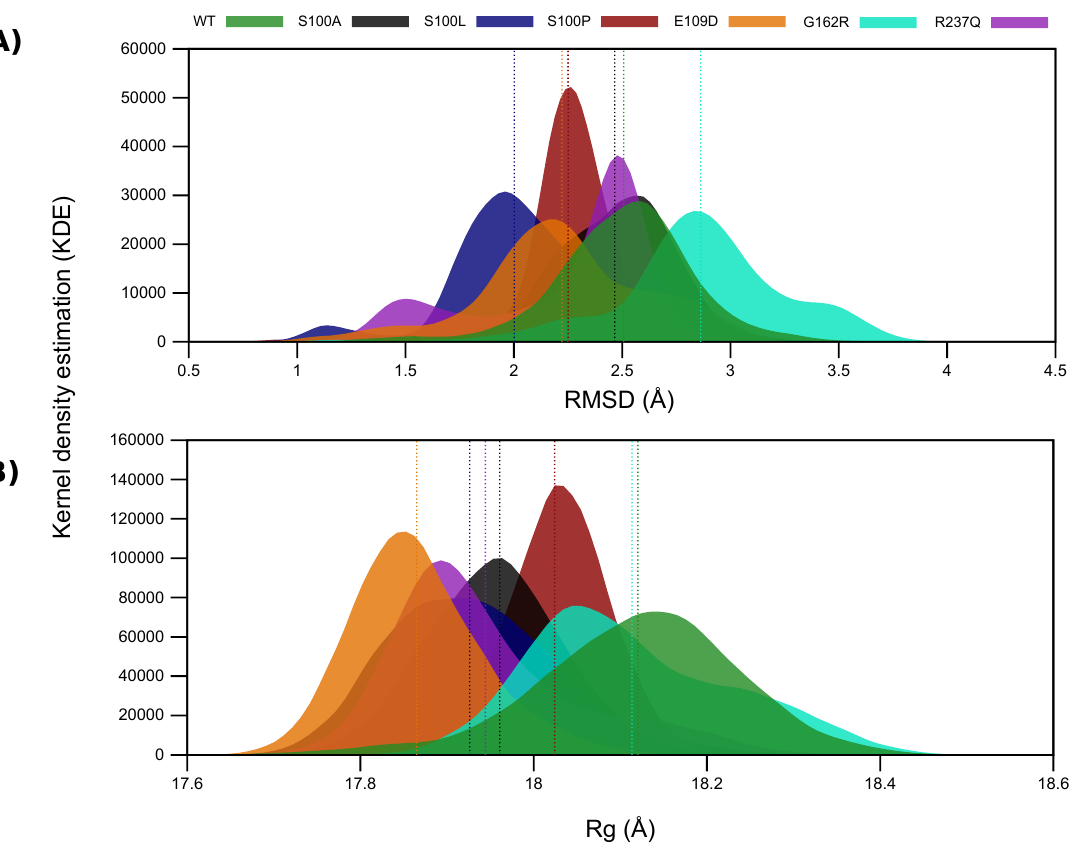
Figure 2. α -carbon RMSD and Rg distribution of the WT and variant proteins using the kernel density estimation. ( A ) RMSD; ( B ) Rg. The mean RMSD and Rg of the WT and variant proteins is presented as the dashed lines on each plot, and the colour of the dashed line is representative of the mean of the same coloured plot. The x -axis represents the sampled conformation RMSDs, and the y -axis peaks represent the RMSDs of the most sampled